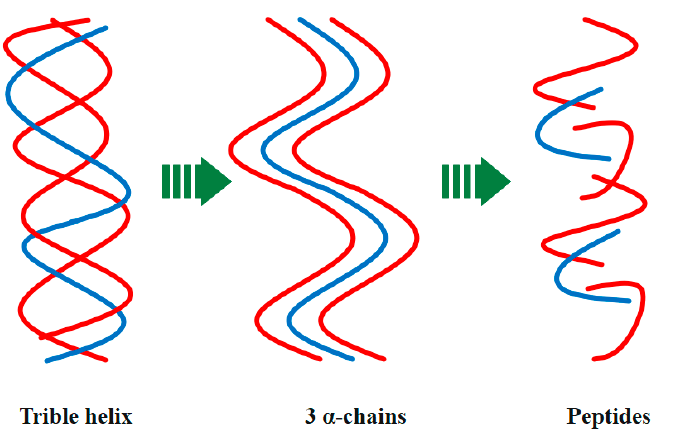
Figure 7. Representative scheme of type I collagen denaturation into low-molecular-weight peptides (red and blue).